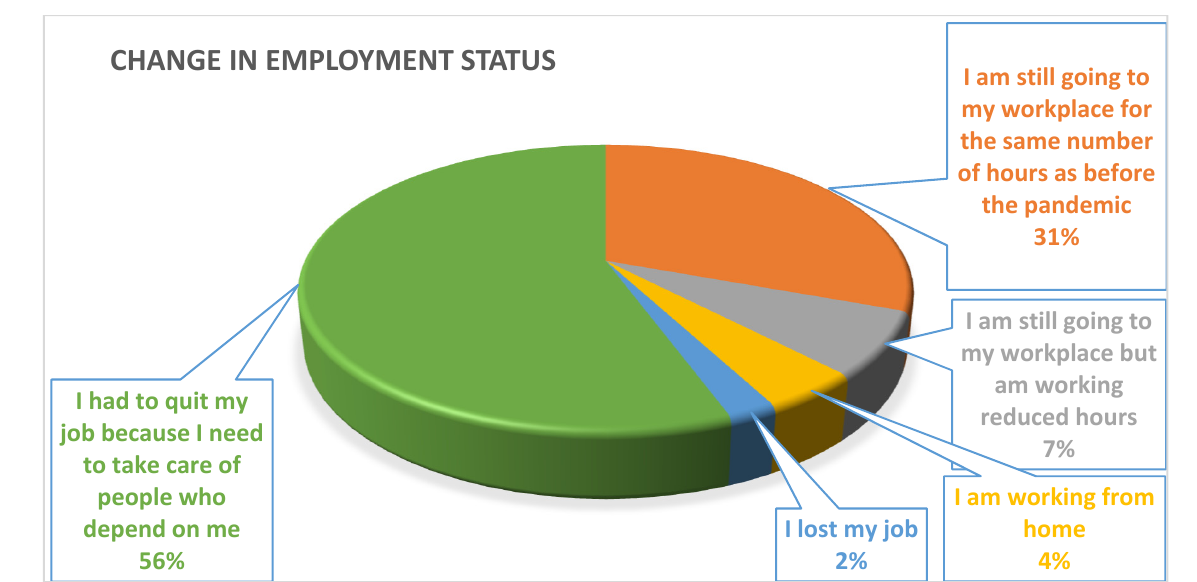
Figure 1. Changes in Employment Status during Corona Pandemic.